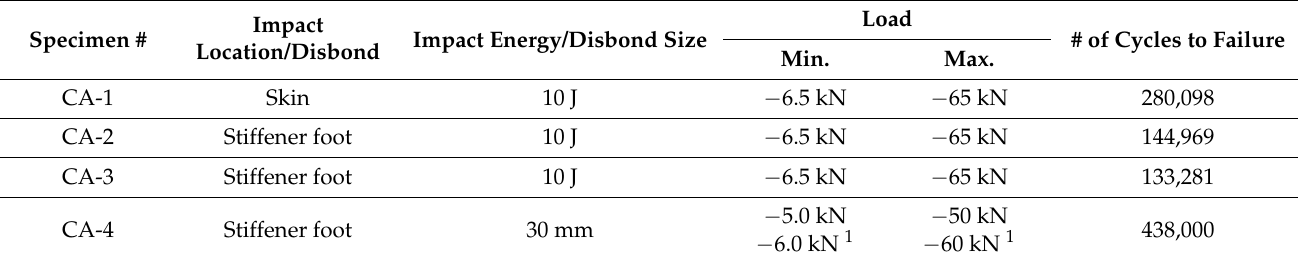
Table 1. Constant amplitude fatigue test campaign details.